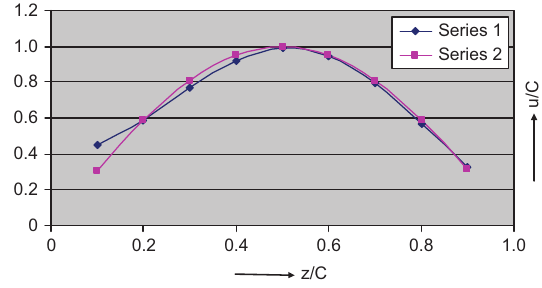
Figure 3 Displacement pattern for half sine wave rectifi er.